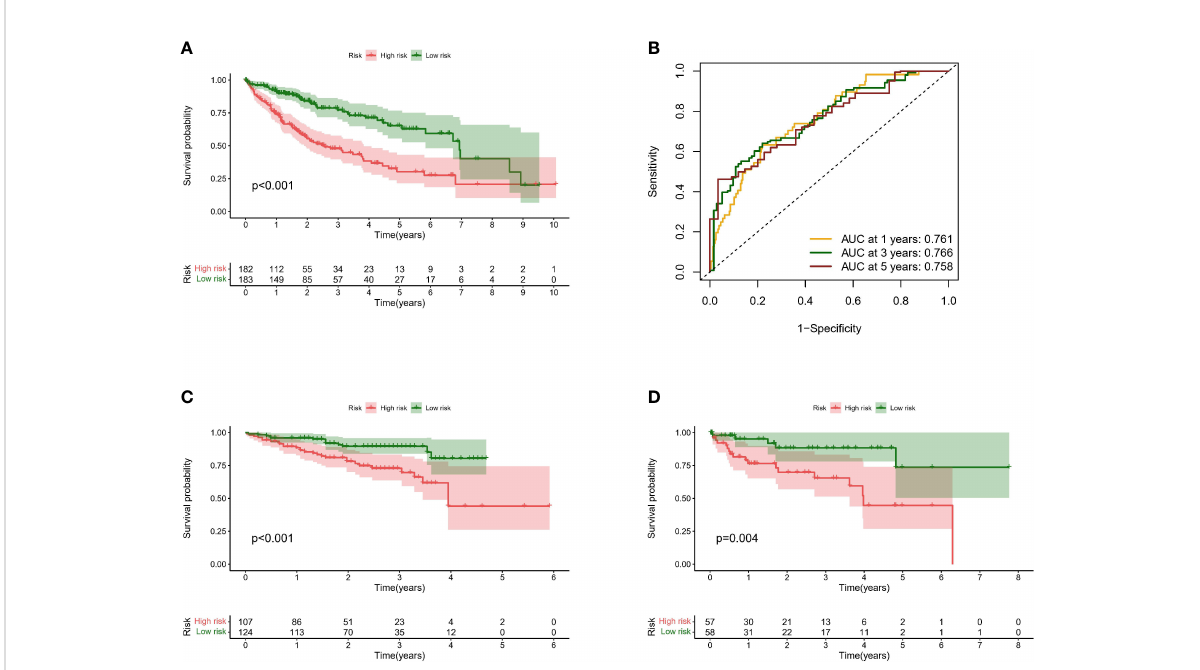
FIGURE 7 Validation of predictive models for overall survival in HCC patients (A) . Line graph showed risk score and possible prediction of patient survival in the TCGA dataset sample (B) . Line chart showed the area under the curve for the training cohort at 1, 3, and 5 years showed survival predictions (C) . Line graph showed possible predictions of survival for high-risk and low-risk samples in the ICGA dataset sample (D) . Line graph showed possible predictions of survival for high-risk and low-risk samples in the GEO dataset